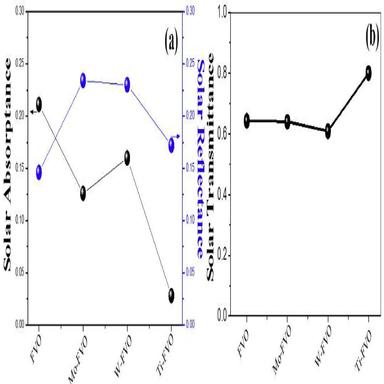
(a) The average solar absorptance, average solar reflectance, and (b) solar transmittance of the as deposited FVO thin films spin coated at 3000 RPM on the quartz substrates, as a function of the dopant variety.